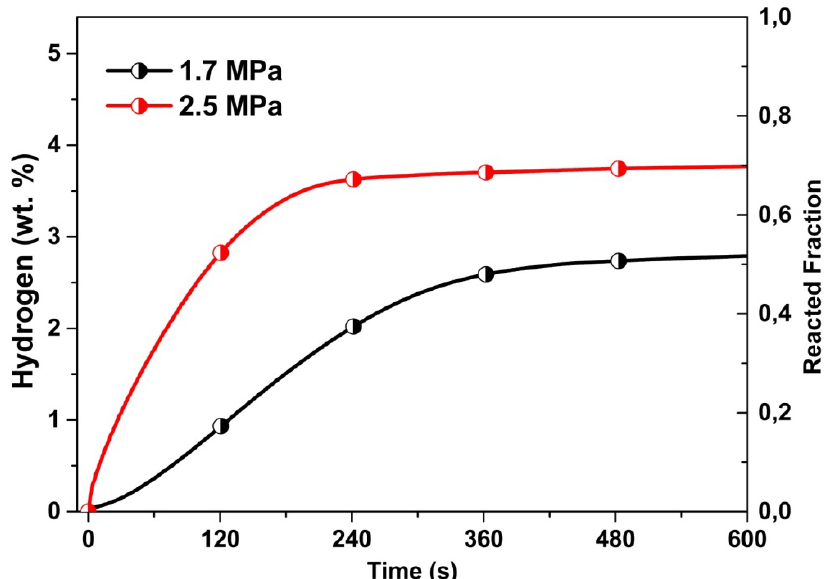
Figure 5. Kinetic curves of hydrogen absorption at 400 °C before quenching under 1.7